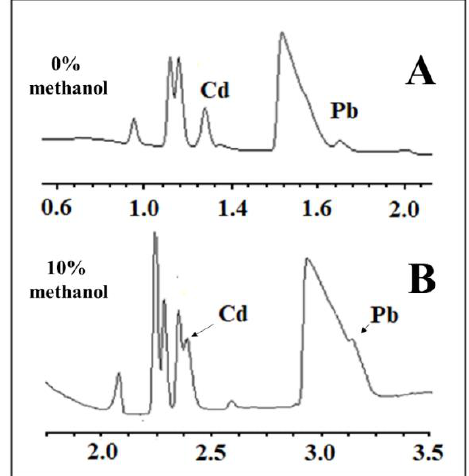
Figure 2. Electropherogram of Cd 2+ , Pb 2+ , and Hg 2+ standards at 2 and 4 µg mL −1 , respectively, in Passiflora incarnata tea samples using the conditions of ( A ) Experiment 7 (0% methanol and temperature at 15 ◦ C) and of ( B ) Experiment 6 (10% methanol and temperature at 22.5 ◦ C) from Table 1. Other conditions: indirect mode, 12 cm effective length, 50 cm full-length capillary, BGE with 5 mmol L −1 imidazole, 6 mmol L −1 HIBA, hydrodynamic short-end injection (0.5 psi by 5 s), and detection at 214 nm.